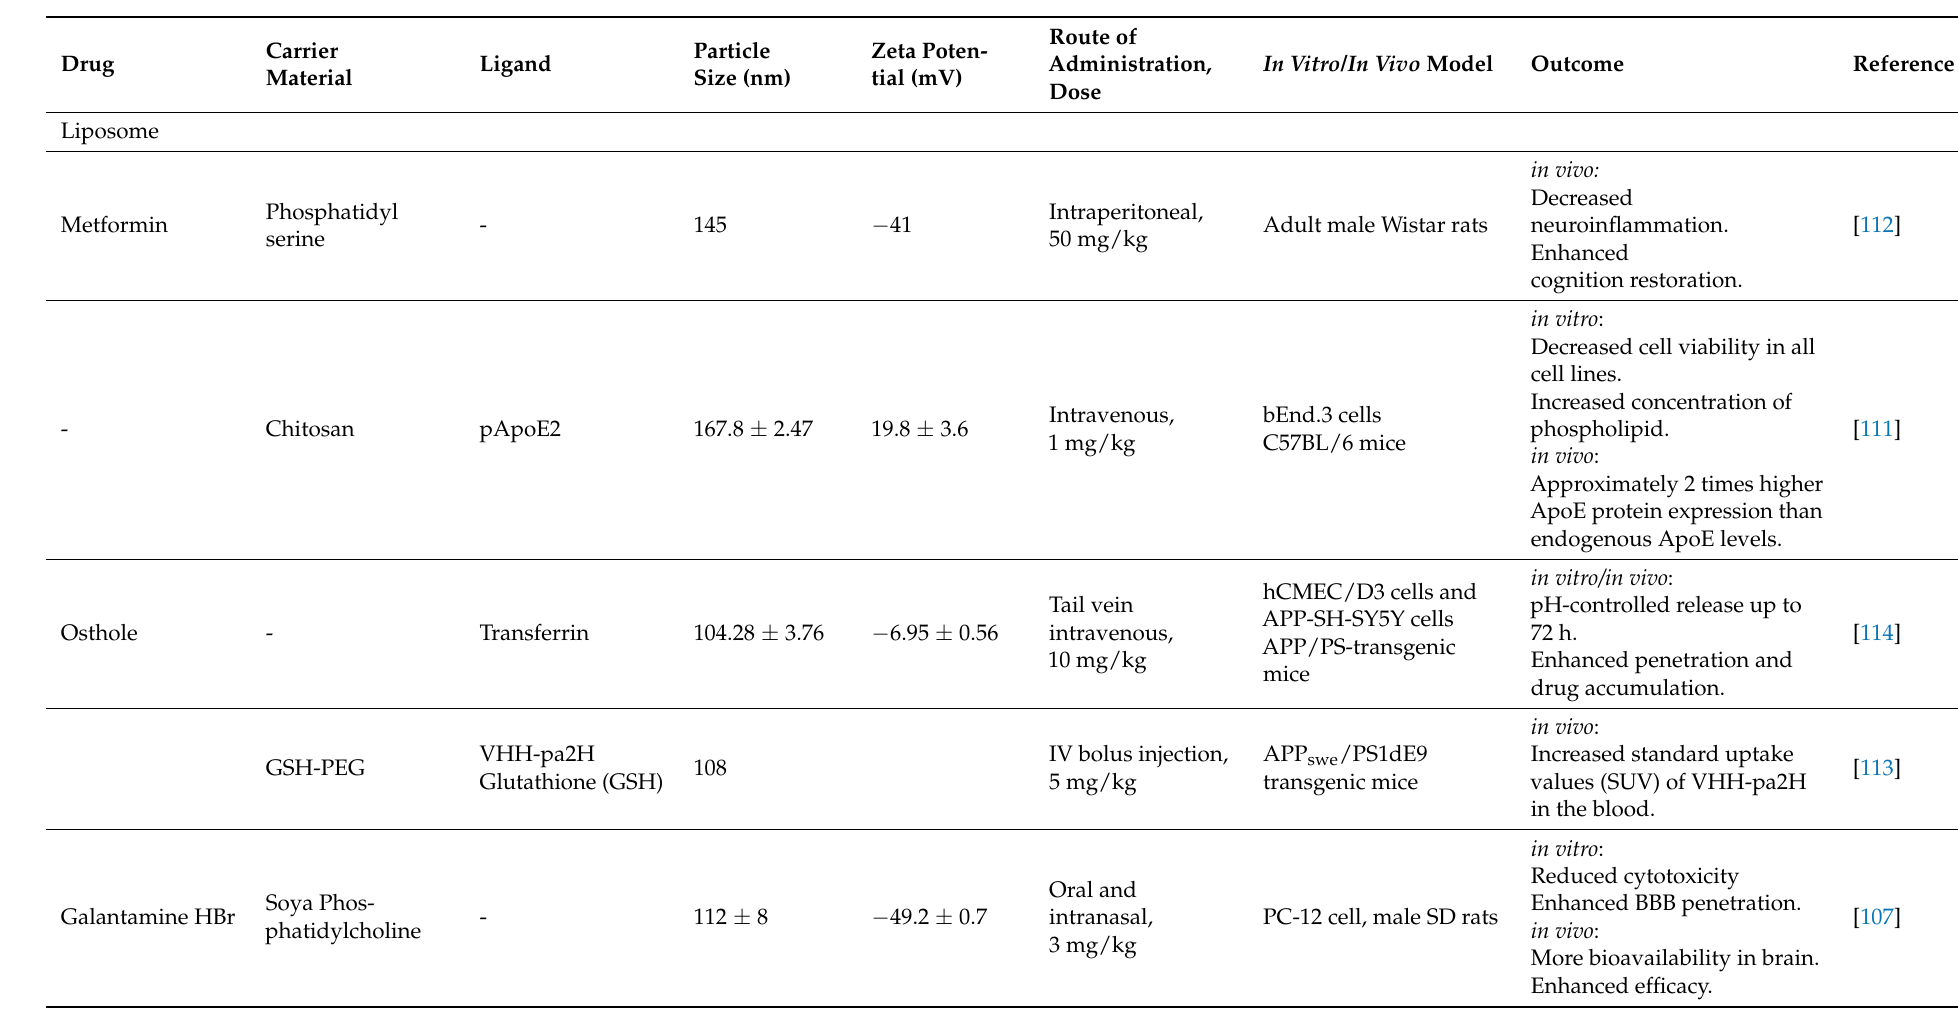
Table 4. Nanoparticle-based drug delivery systems to treat